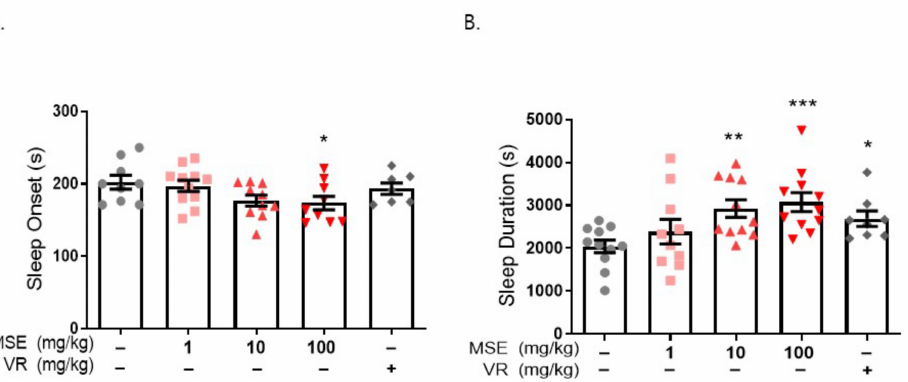
Figure 2. Maydis stigma extracts decrease sleep latency and increase sleep duration. Mice were administered MSE (1, 10, 100 mg/kg) and positive control (valerian root extract; VR, 10 mg/kg) for 7 days orally. Sleeping test was performed on day 8. Sleep latency and sleep duration was measured as described in Section 4. ( A ) Sleep latency (s), ( B ) sleep duration (s). * p < 0.05, ** p < 0.01, *** p < 0.001; Veh vs. MSE and VR (N =